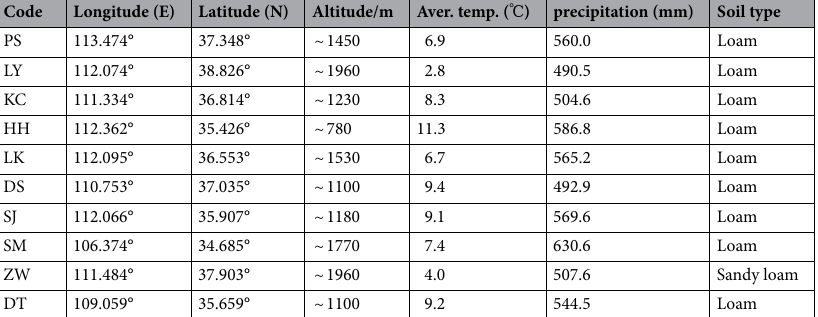
Table 1. The names, geographical locations, climate conditions, and soil types of Quercus liaotungensis provenances. PS Pingsong provenance, LY Luyashan provenance, KC Kangcheng provenance, HH